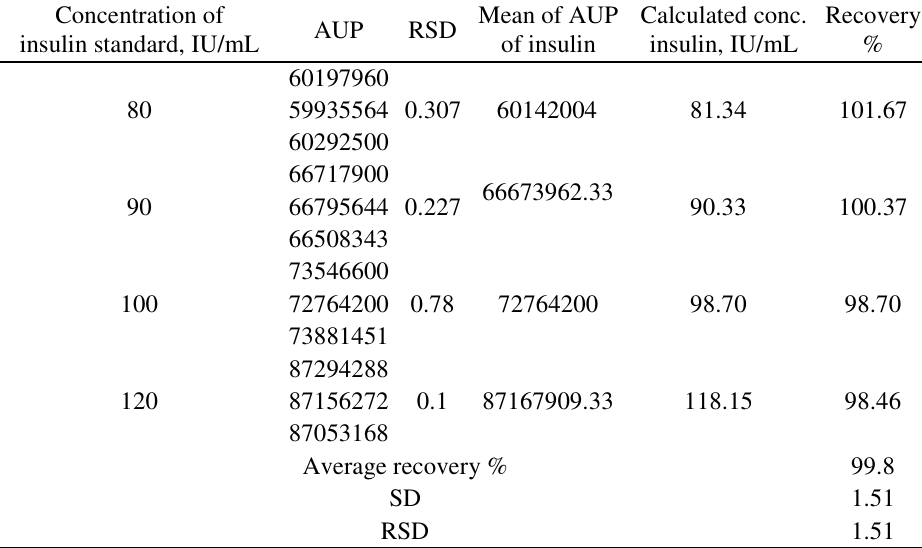
Table 4. Accuracy of the modified RP-HPLC method for determination of recombinant human